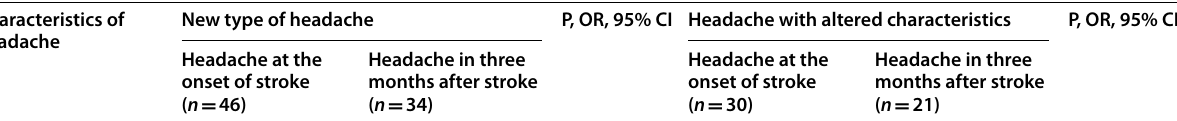
Table 2 Changes in characteristics of persistent headaches during three months compare to initial characteristics at onset of first-ever ischemic